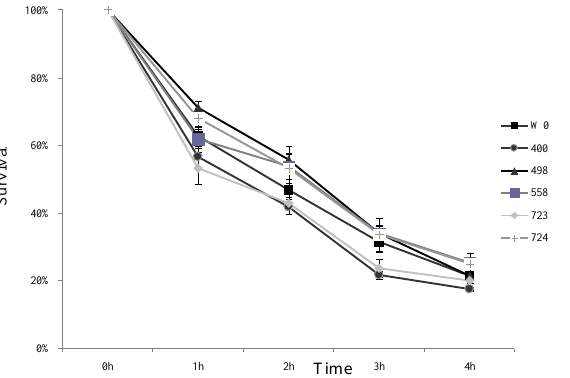
Figure 3. Cell survival (%) of different yeast strains during the high ethanol shock treatment. Data are given as means ± SD, n = 3.